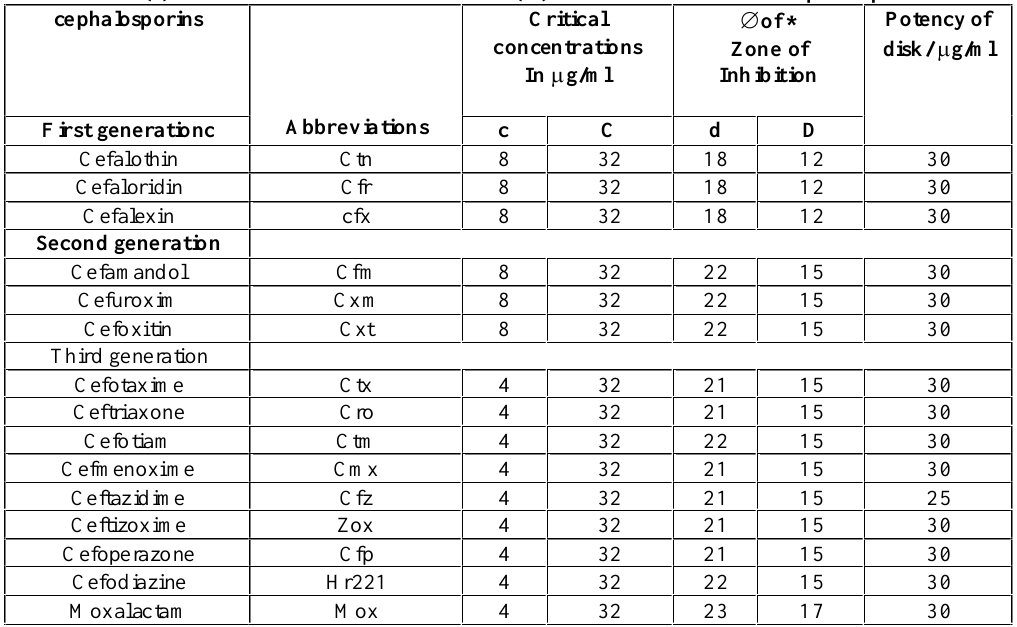
Table (1) Standard of MICs and diameters (  ) of zone of inhibition of cephalosporins